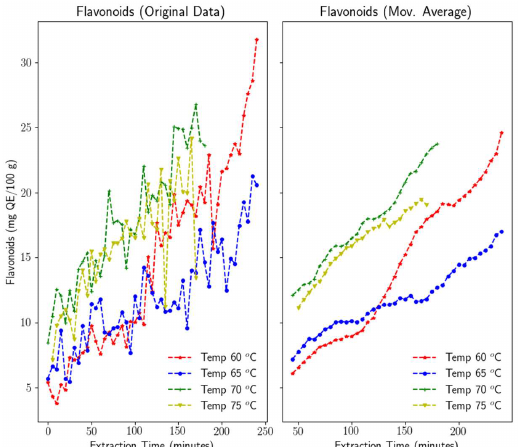
Figure 5. Flavonoid content with different extraction times and at different temperatures.